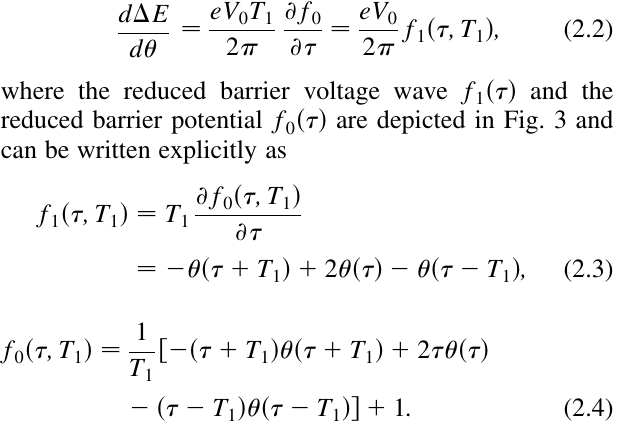
(cid:4) (cid:5); T (cid:5) and rf force f 0 1